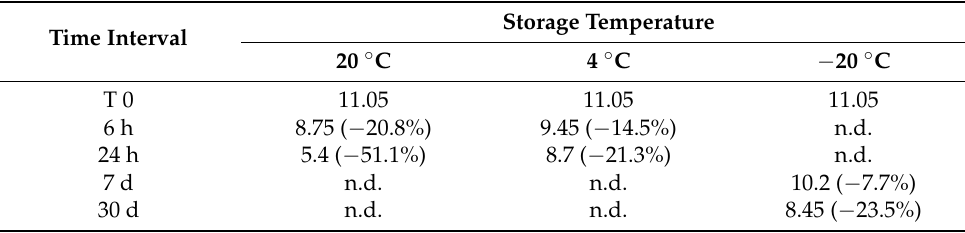
Table 2. Deviation from the baseline concentration of PTH (pg/mL) expressed in % at different storage temperatures. h: hours; d: days; n.d.: not done. Time